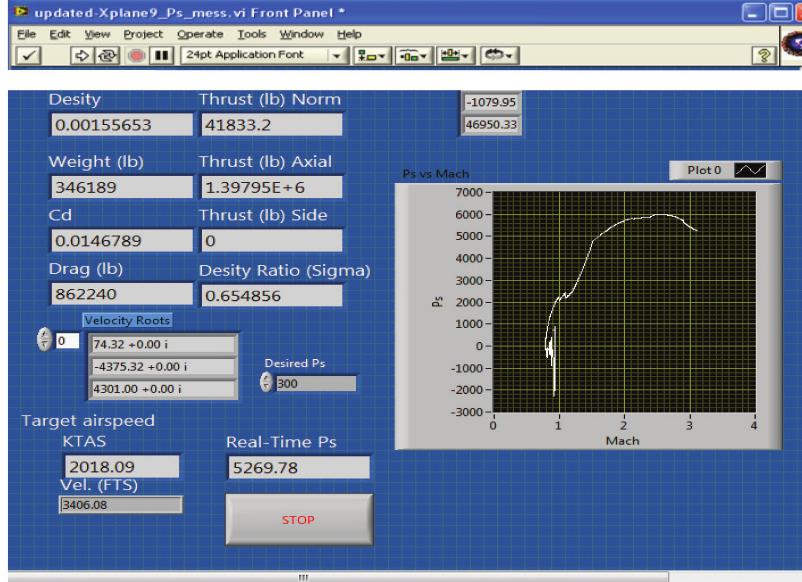
Fig. 2. Real-time energy management display (View